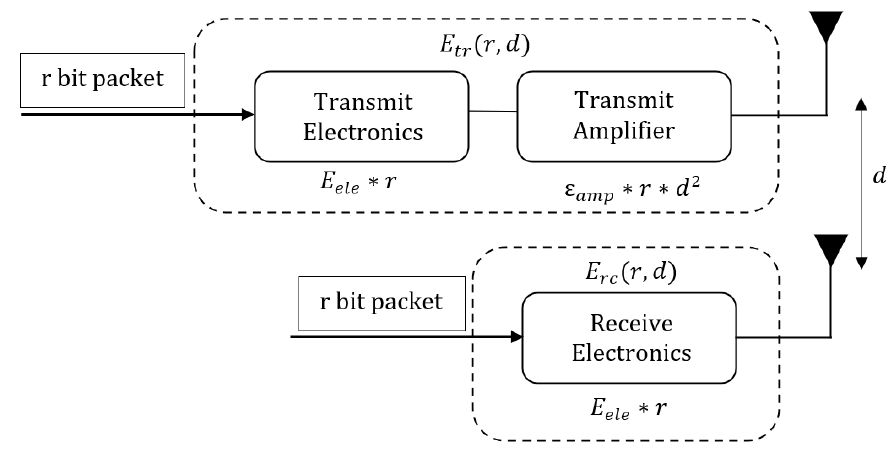
Figure 1. Radio Model. Reprinted with permission from [16]. Copyright 2000